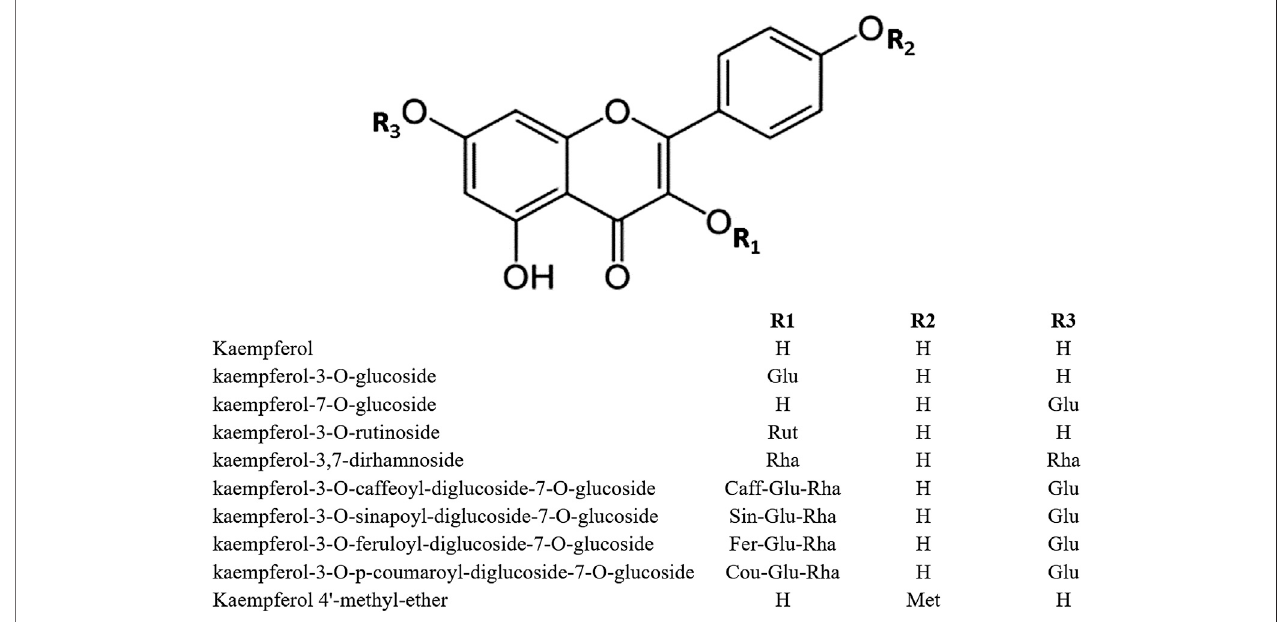
FIGURE 1 | Structure of kaempferol and its